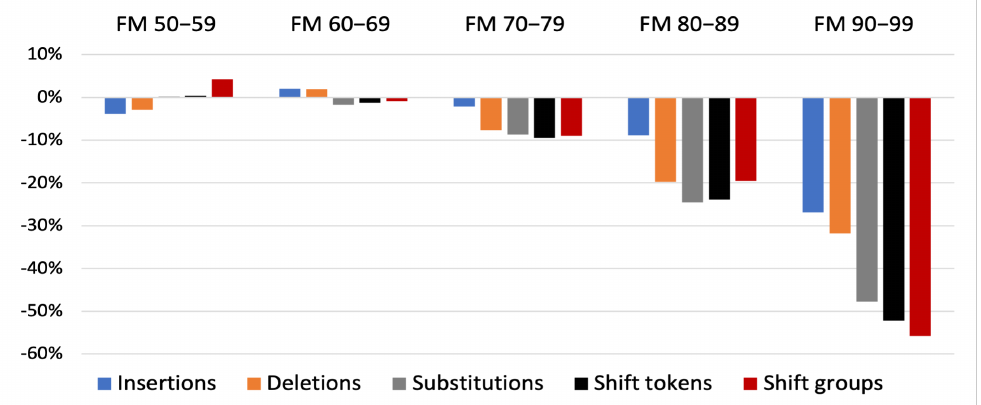
Figure 4. Percentage of difference in total number of edits, per edit type, when NFR output is compared to the baseline NMT output for different fuzzy match (FM) ranges.